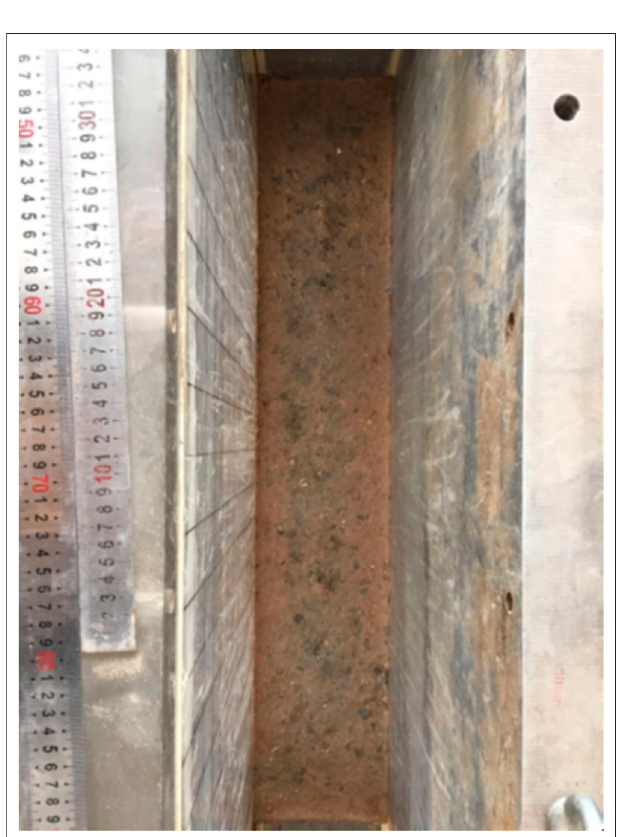
FIGURE 4 | Paving and compaction of the fi